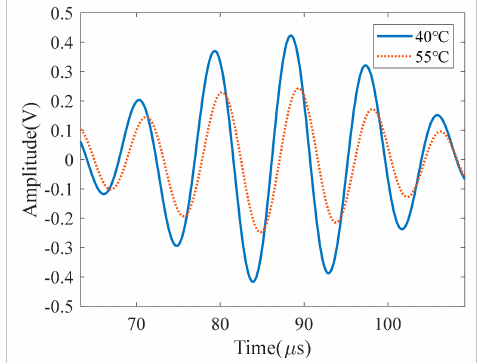
Figure 1. Typical signal di ff erences under di ff erent